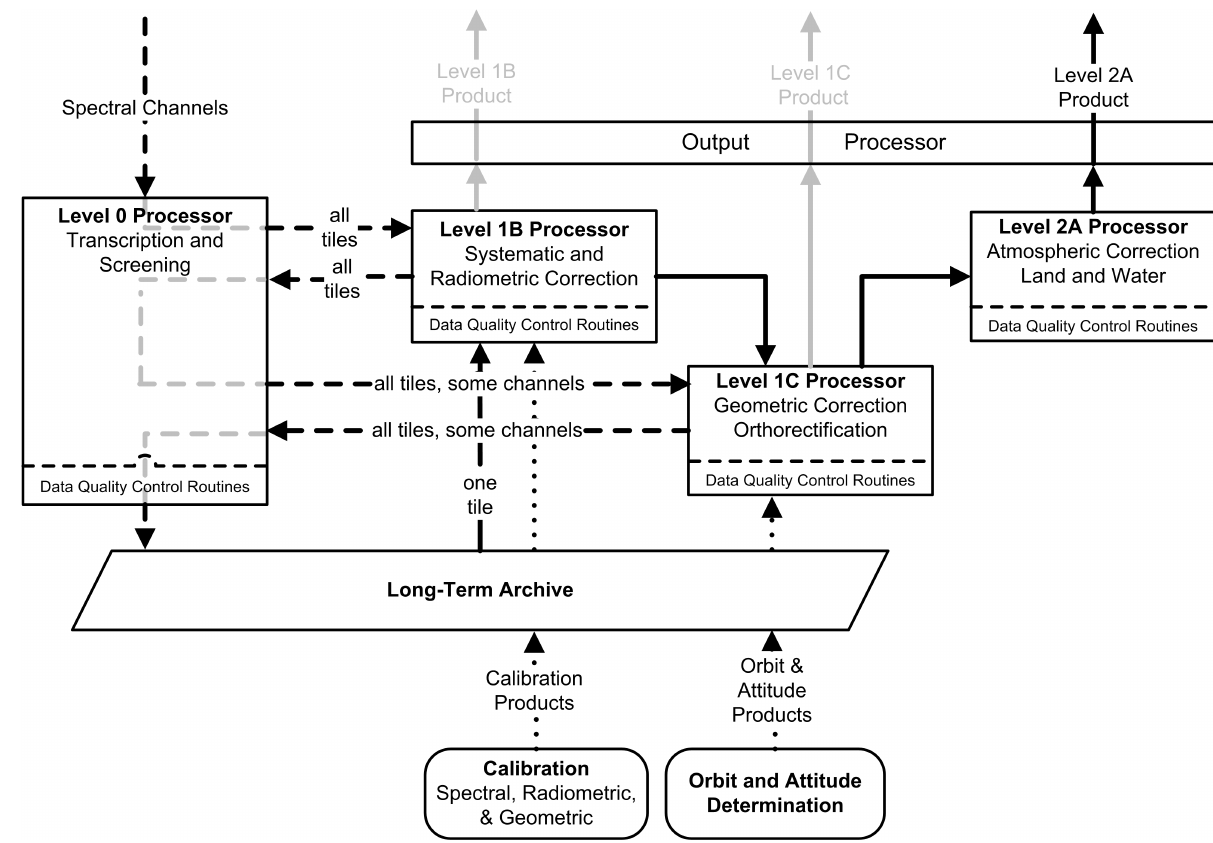
Figure 8. Scheme of the processing chain for the generation of data products at the EnMAP ground